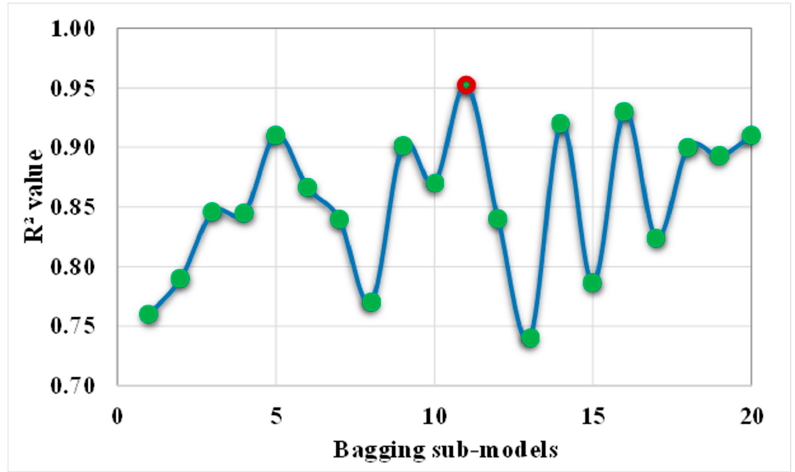
Figure 21. Result of the bagging sub-models.